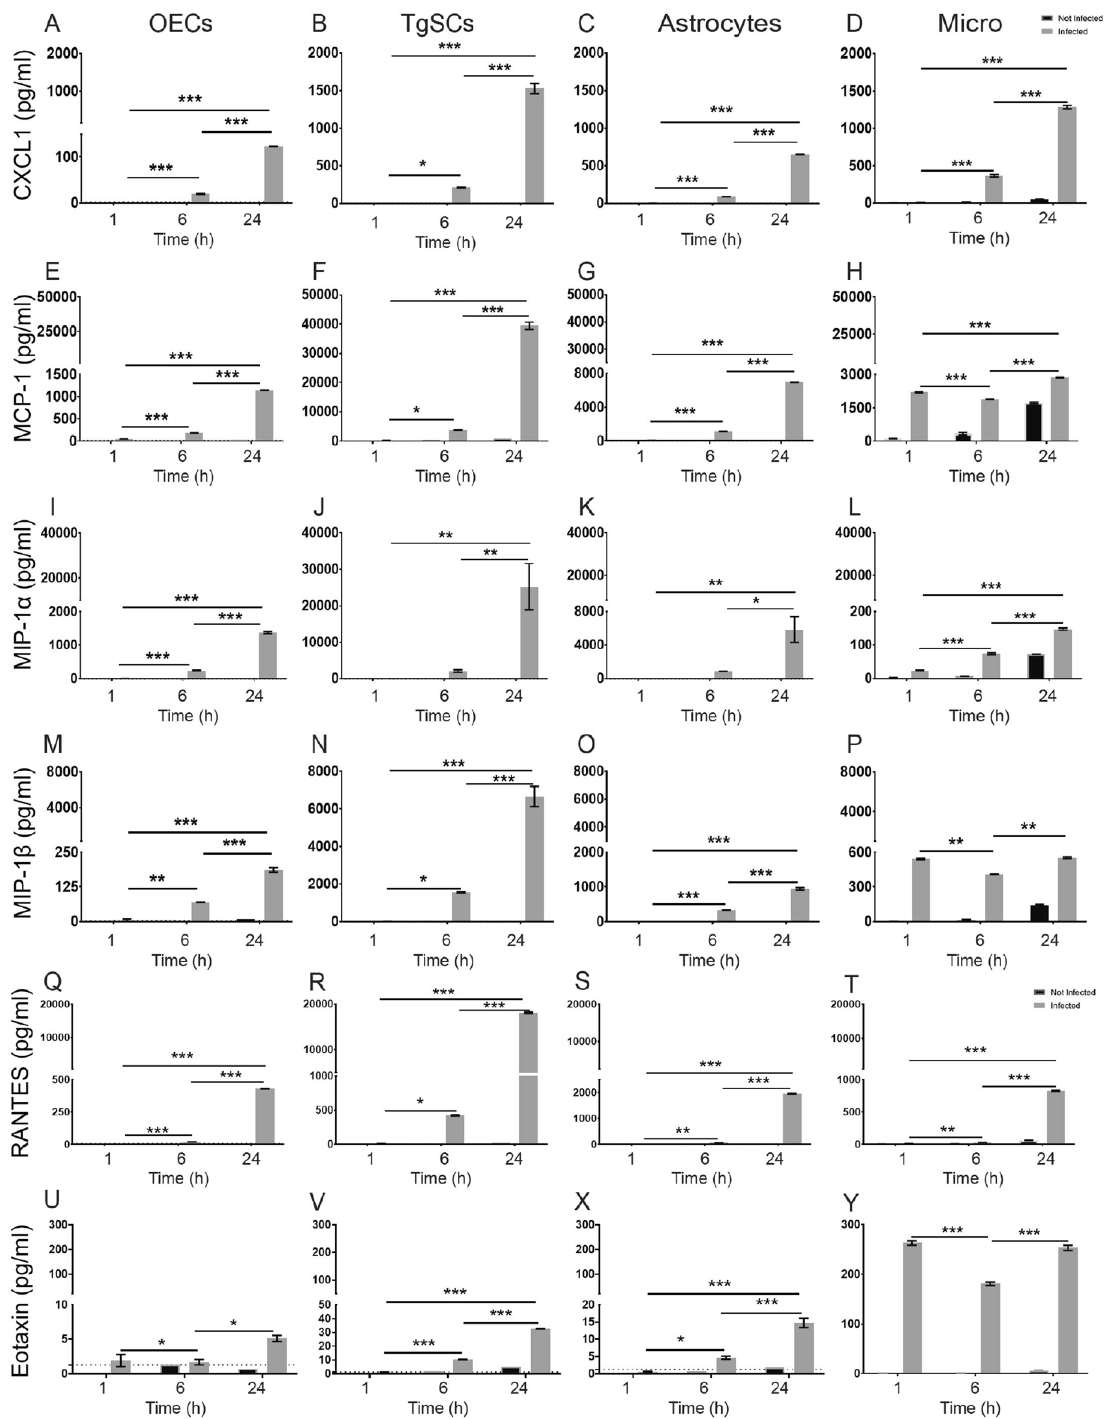
Figure 6. Production of chemokines by the different glial types following exposure to S. aureus . Chemokine production by OECs, TgSCs, astrocytes and microglia were measured using multiplex ELISA at 1 h, 6 h and 24 h post exposure to S. aureus . CXCL-1( A – D ), MCP-1 ( E – H ), MIP-1α ( I – L ), MIP-1β ( M – P ), RANTES ( Q – T ) and Eotaxin ( U – Y ). Data shows mean ± SEM. * p < 0.05, ** p < 0.01, *** p < 0.001 (two-way ANOVA with Tukey’s multiple comparison test), n = 2 technical replicates (100,000